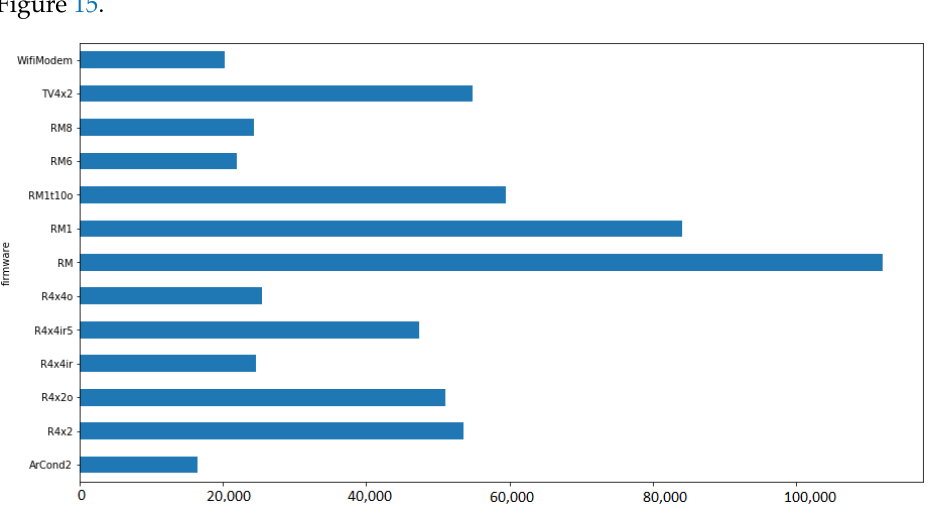
Figure 15. Readings count by firmware